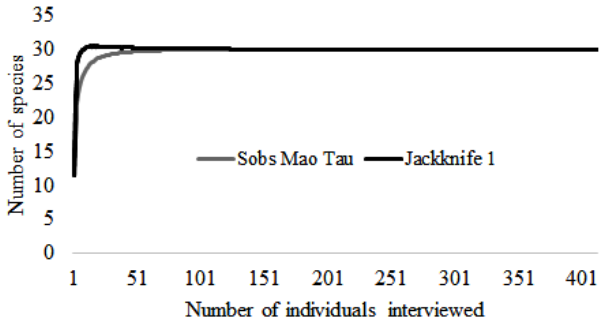
Fig. 2 . Rarefaction curves showing the number of observed mammal species cited by interviewees of the municipalities surveyed in Brazil’s semiarid region, with 95% confidence interval for the observations (calculated with 1000 randomizations), and the number of species estimated by Jackknife 1.